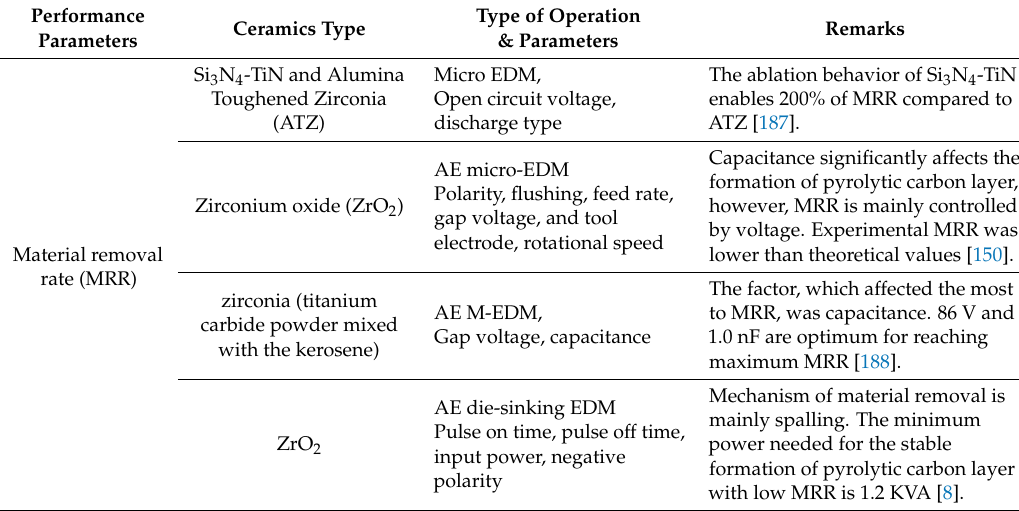
Table 5. Summary of EDM performance characteristics for Conductive/non-conductive